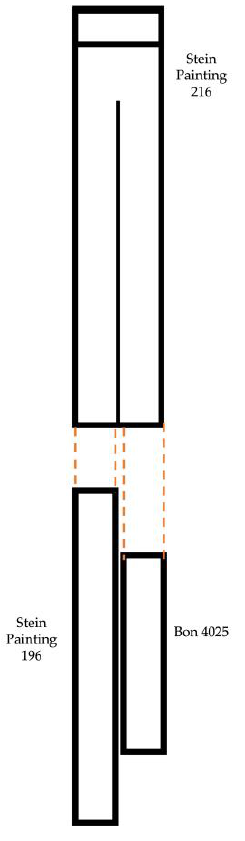
Figure 6. Schematic drawing of reconstructed Stein Paintings 216 with Stein Painting 196 and Bon 4025 (drawing by author).